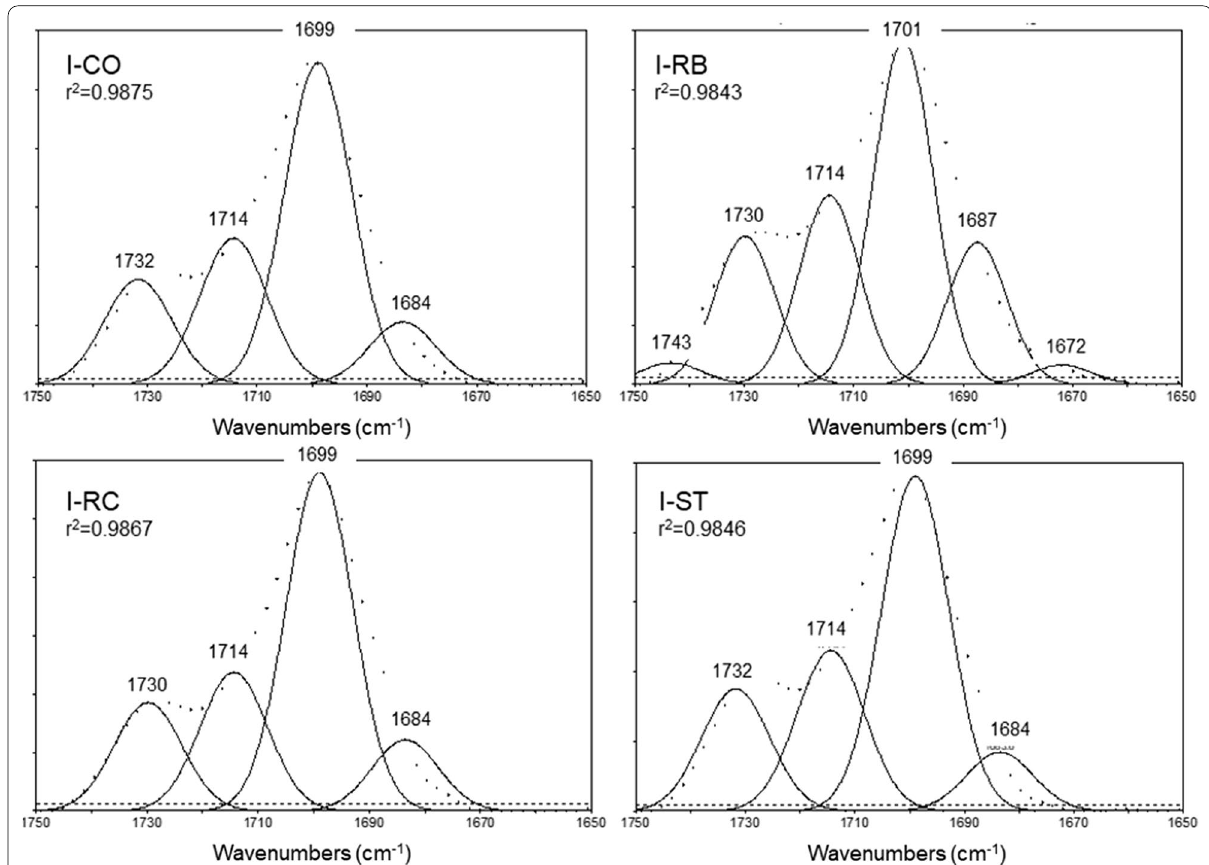
Fig. 5 Gaussian curve-fitting of the ester peak of Invisalign (I) before (CO) and after treatments with Retainer Brite (RB), Retainer Cleaner (RC) and Steraligner (ST) cleaners. After RB treatment, two additional peaks appeared (1743 cm − 1 , 1672 cm − 1 ) and the intensity of the peak at 1687 cm − 1 was increased indicating changes in the H–bonding status of the ester groups (1750–1650 cm − 1 range, absorbance scale, dotted lines: original spectra, r 2 : coefficient of determination for the goodness of curve-fit)